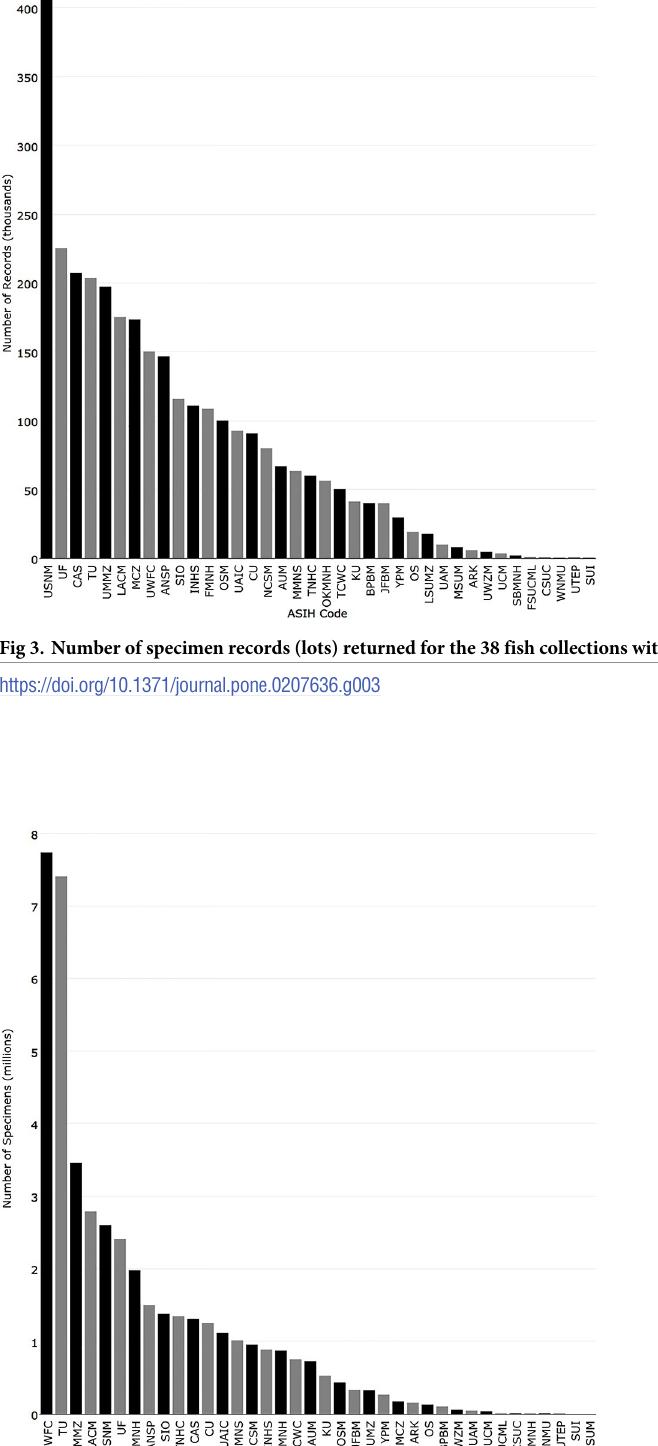
PLOS ONE | https://doi.org/10.1371/journal.pone.0207636 December19,